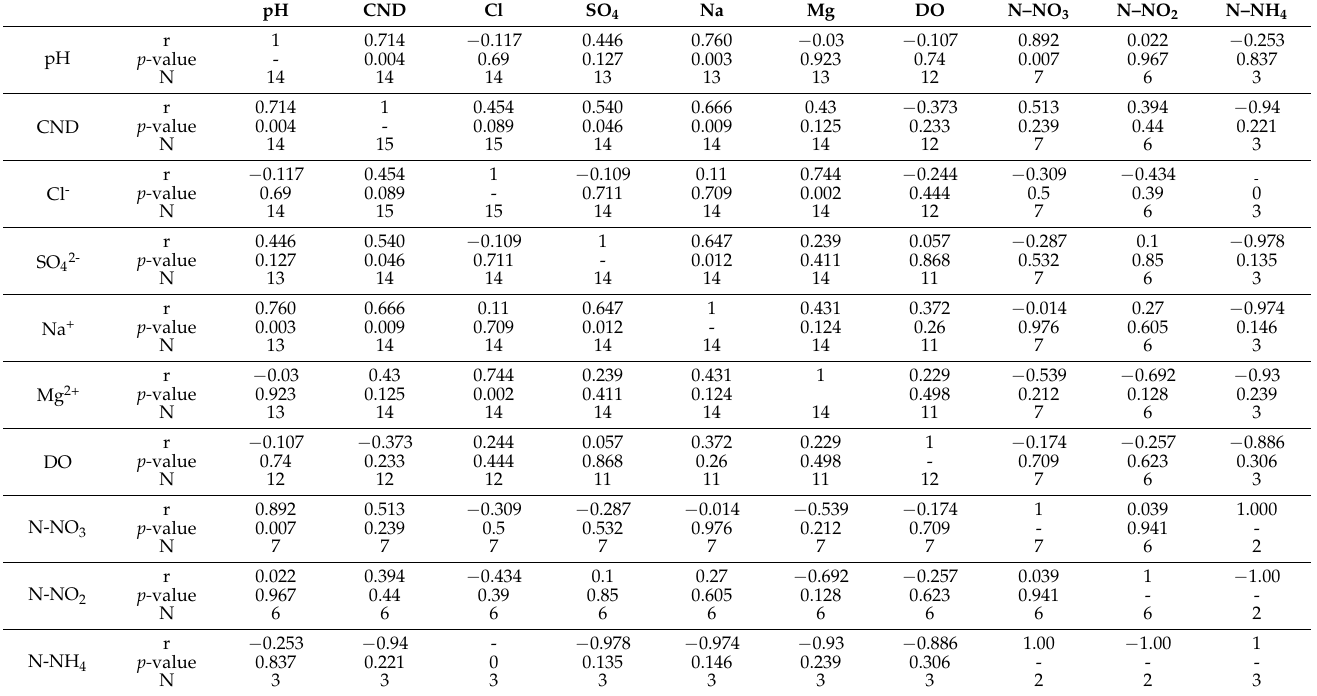
Table 3. Correlation coefficients and p -values of the studied water quality parameters for the